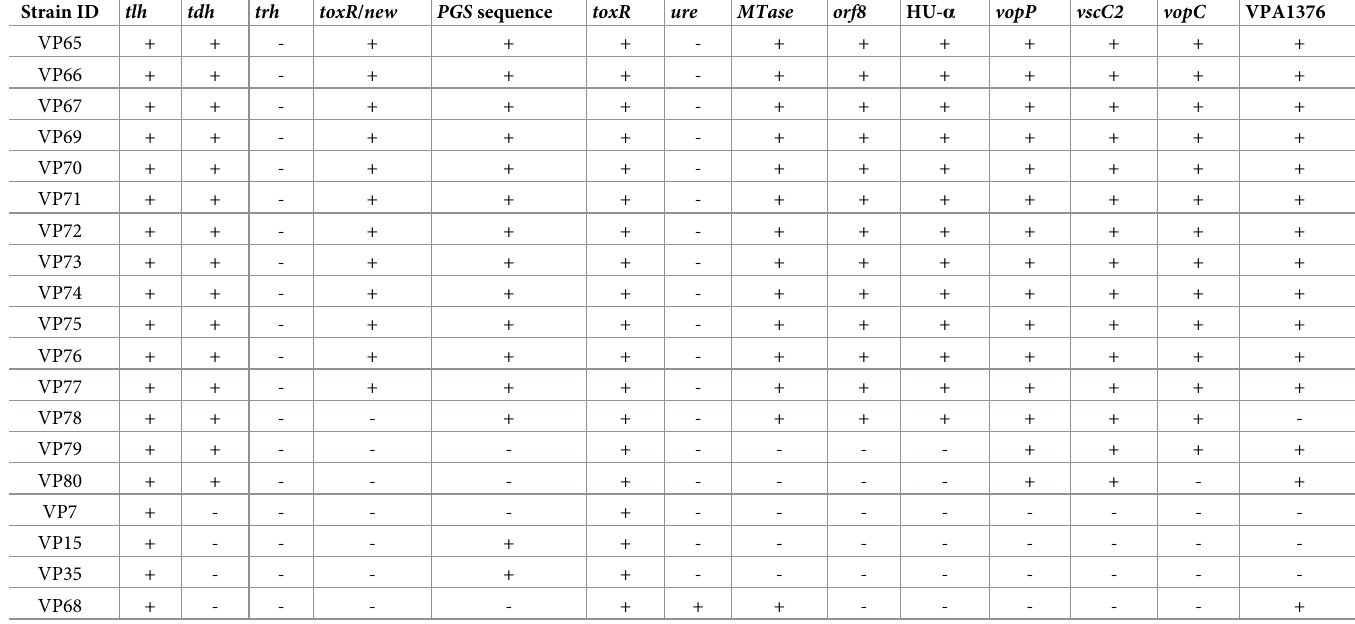
tively strong motor